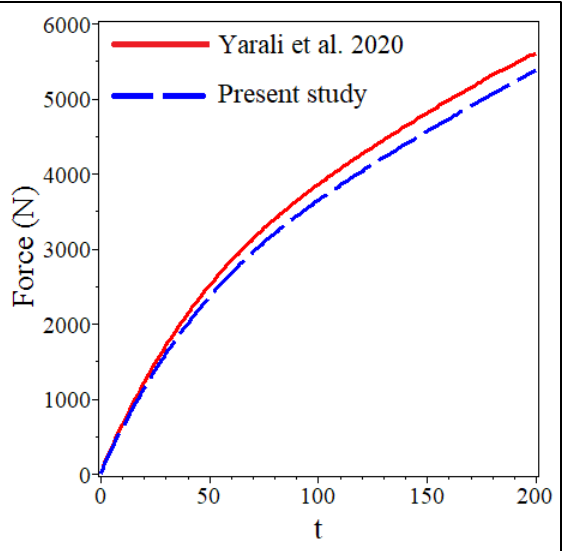
Figure 5. Comparison between the results of this study and [51] for the visco-hyperelastic analysis. Table 1. Comparison between the maximum deflection (mm) results of the present study and [53] for aluminum circular